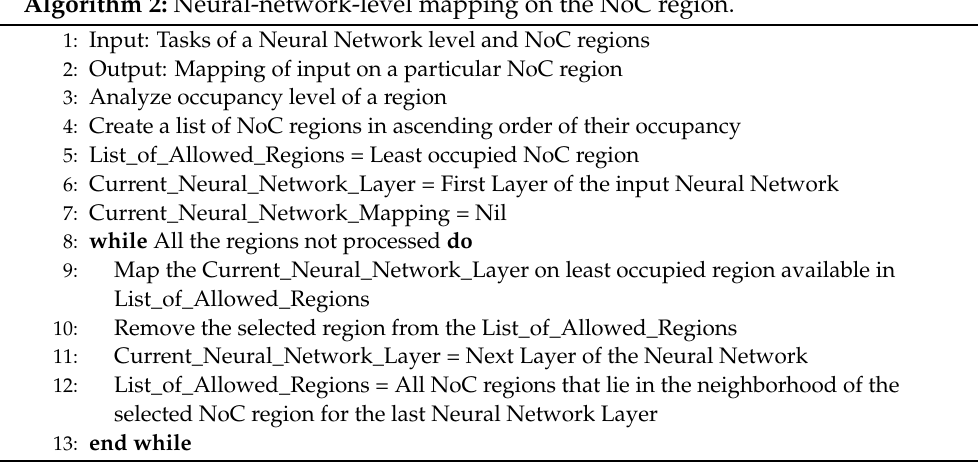
Figure 3. AI sub-task mapping on various NoC regions. Algorithm 2: Neural-network-level mapping on the NoC